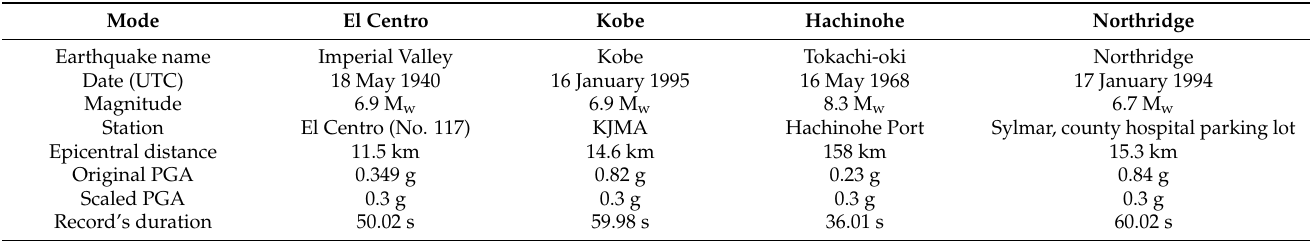
Table 3. Accelerogram data for the El Centro, Hachinohe, Kobe, and Northridge records that were used in this